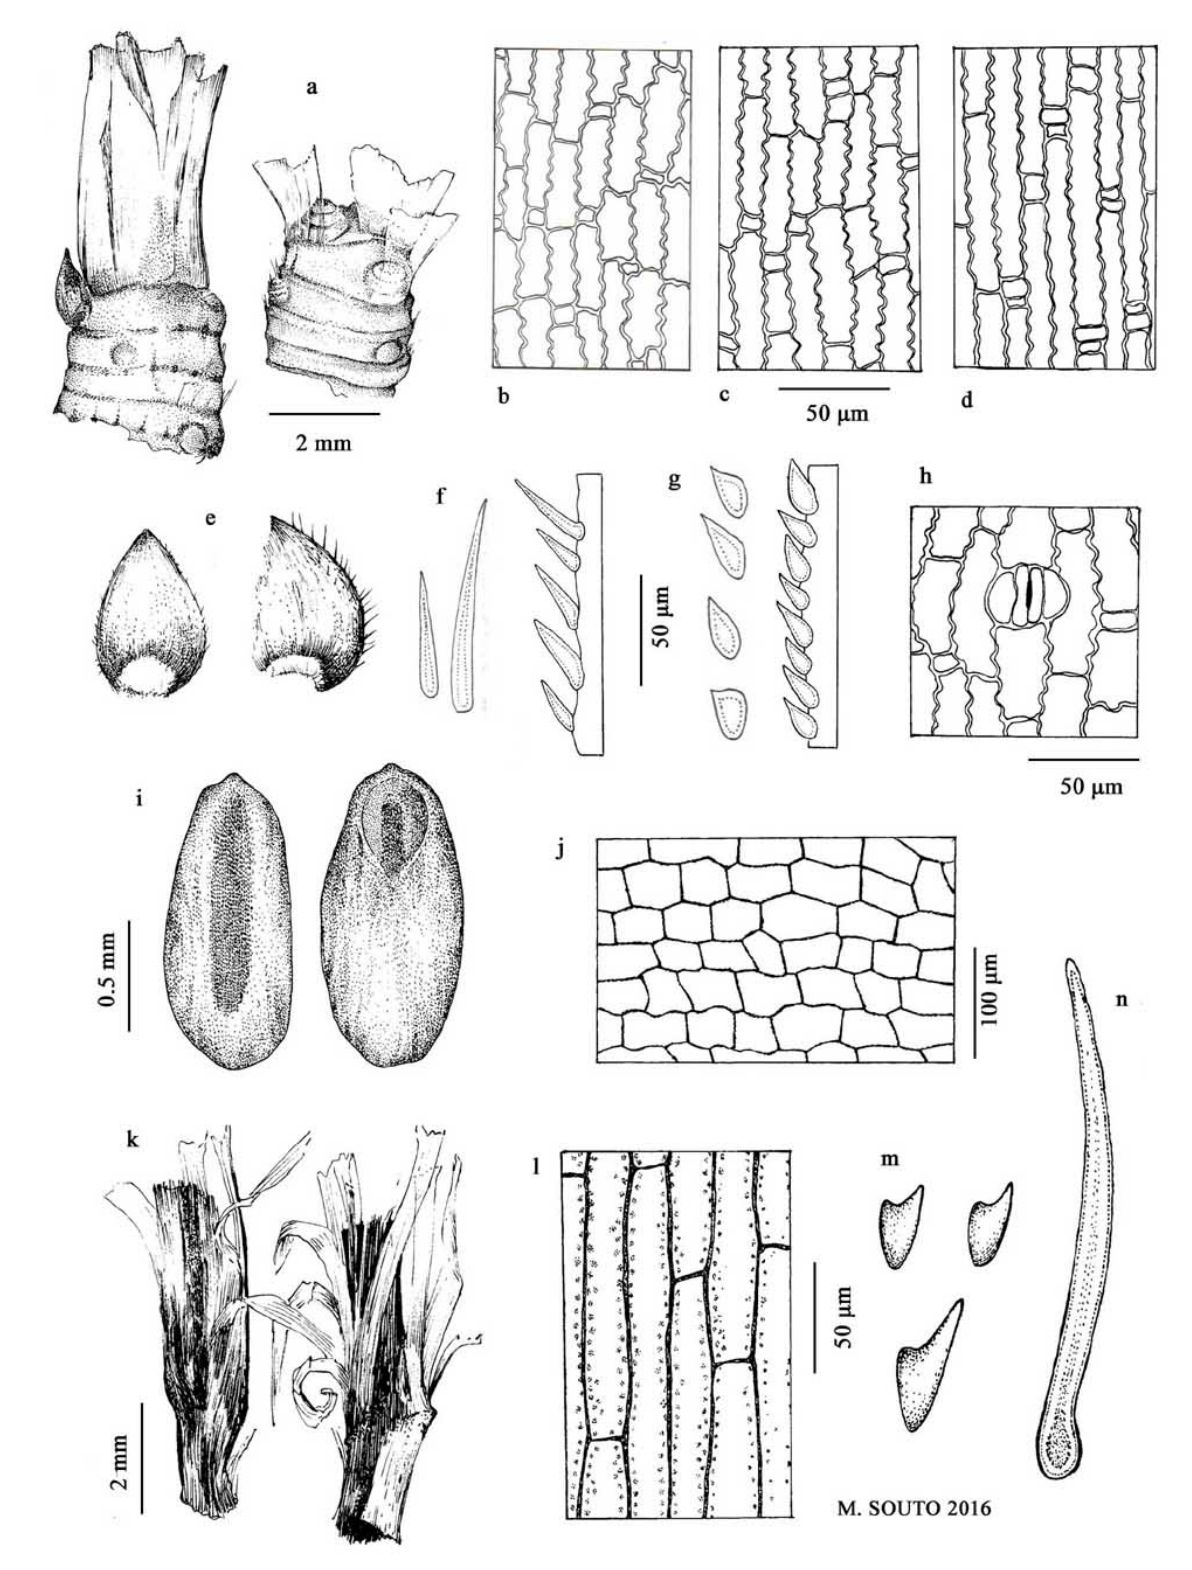
Figure A3. Molinia caerulea : a) rhizome fragment with axillary buds and leaf bases; b) rhizome epidermal cells; c) epidermal cells of leaf base; d) adaxial leaf epidermal cells intermixed with silica bodies; e) bud scales; f) bud scale hairs; g) leaf blade hairs; h) leaf blade stomatal complex; i) caryopsis; j) epidermal caryopsis cells. Agrostis curtisii : k) rhizome fragments; l) epidermal cells of leaf base; m) leaf prickles (lateral view); n) unicellular leaf